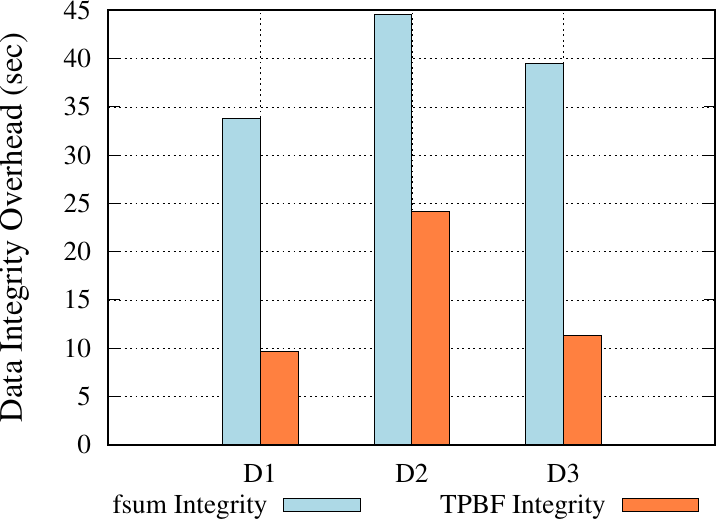
Figure 9. Computational overhead comparison of fsum and